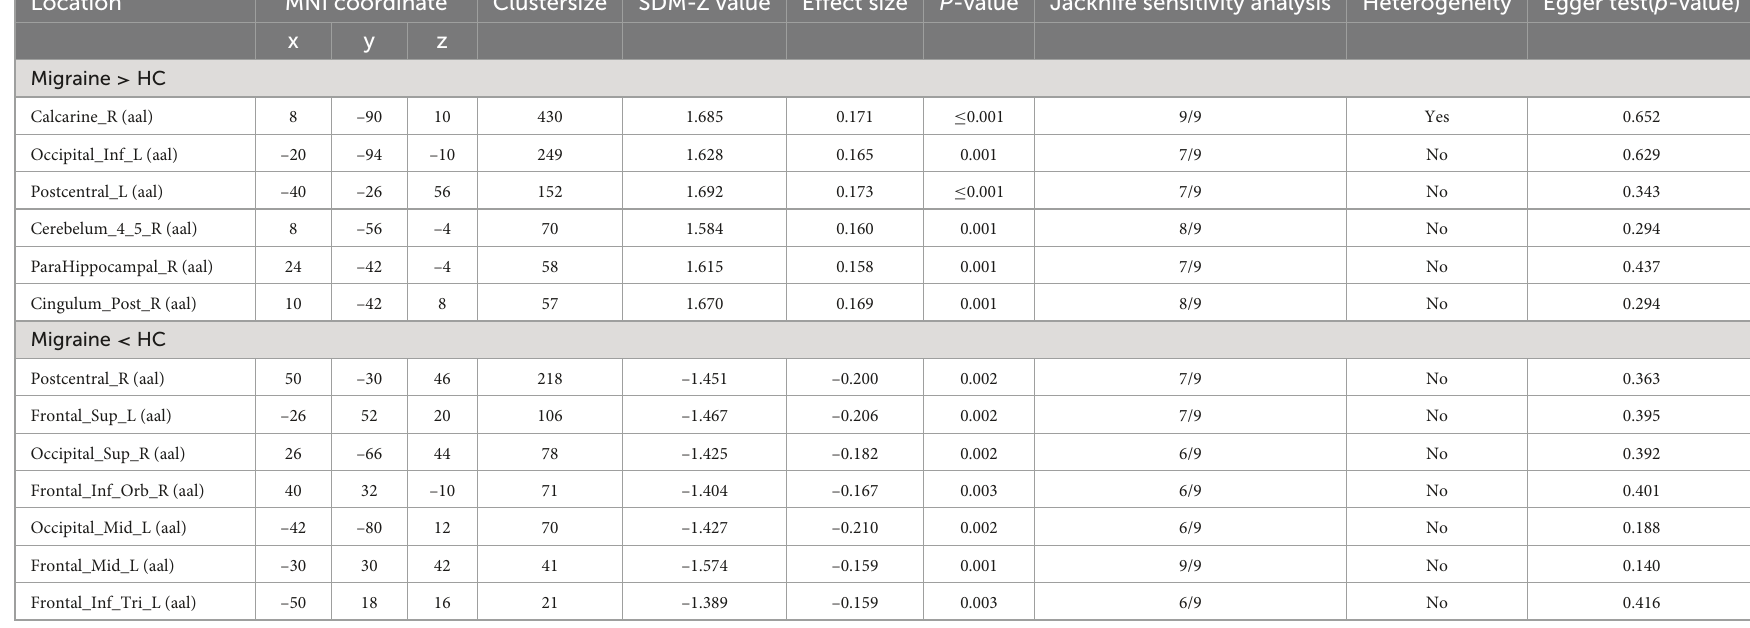
TABLE 2 Clusters showing resting-state functional connectivity (rs-FC) differences in migraine patients compared with healthy control (HC). Location MNI coordinate Clustersize SDM-Z value Effect size P -value Jacknife sensitivity analysis Heterogeneity Egger test( p